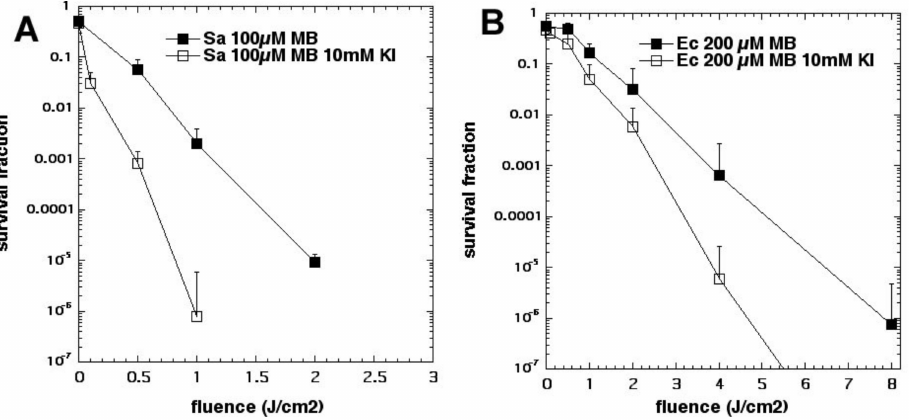
Figure 8. MB mediated aPDI is potentiated by potassium iodide. ( A ) S. aureus ; ( B ) E. coli. Figure adapted from data contained in